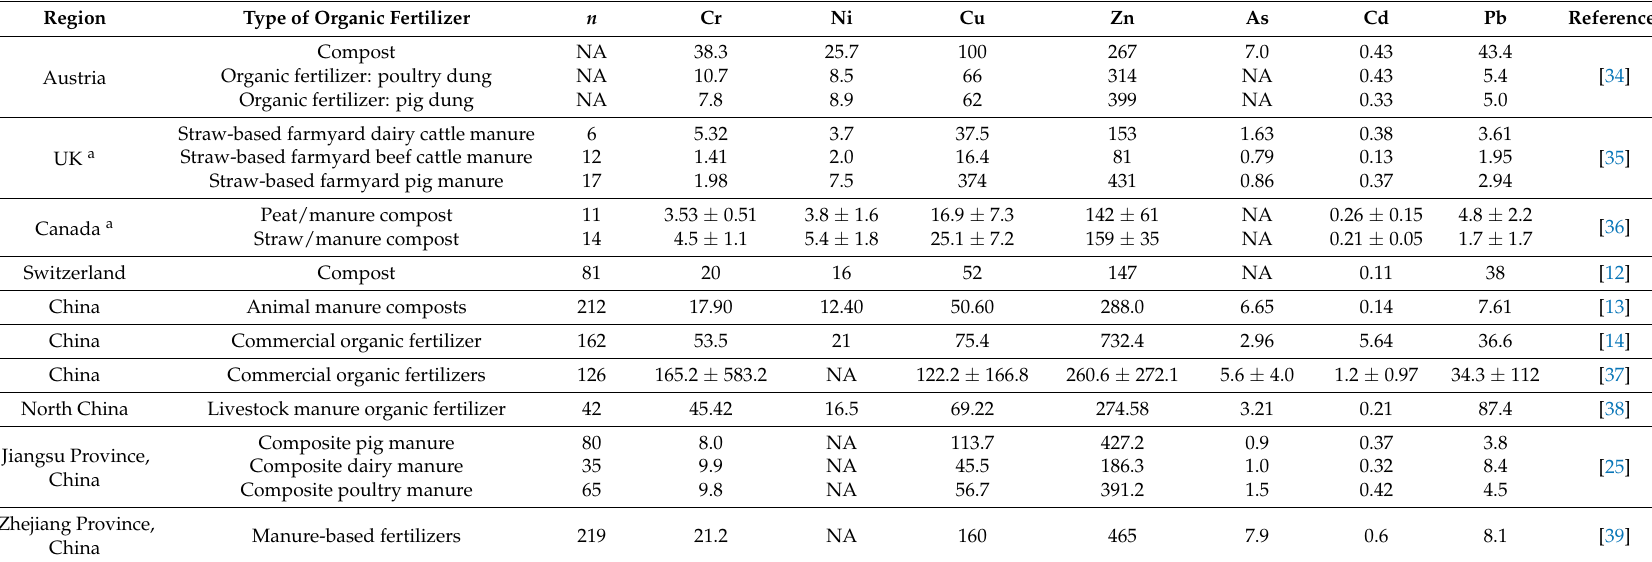
Table 5. Trace metal concentrations in compost in published articles (based on median/mean value) (mg · kg − 1 ).